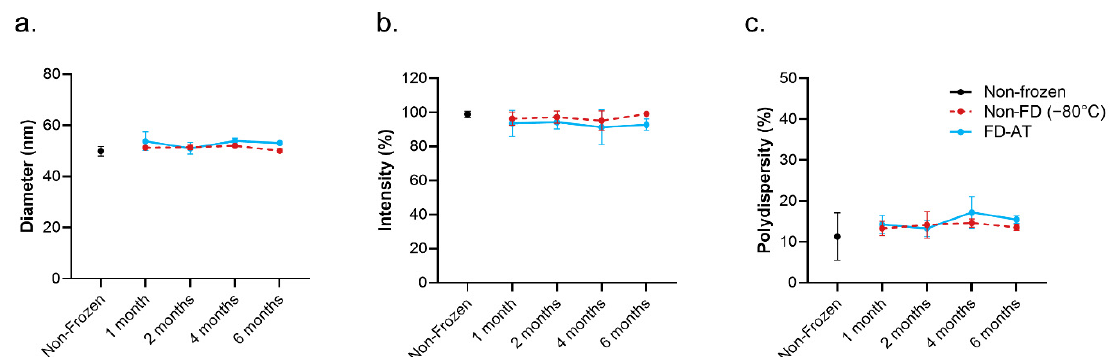
Figure 4. Freeze-dried RBD-cVLP (SARS-CoV-2) vaccine is stable at ambient temperature for up to 6 months. DLS measurement of ( A ) hydrodynamic diameter, ( B ) percentage intensity, and ( C ) poly- dispersity of the main peak population of freeze-dried RBD-cVLPs stored at ambient temperature or non-freeze-dried RBD-cVLP stored conventionally at − 80 ◦ C for 6 months compared to a non-frozen RBD-cVLP reference sample. Results show the mean ± SD of measurements performed in